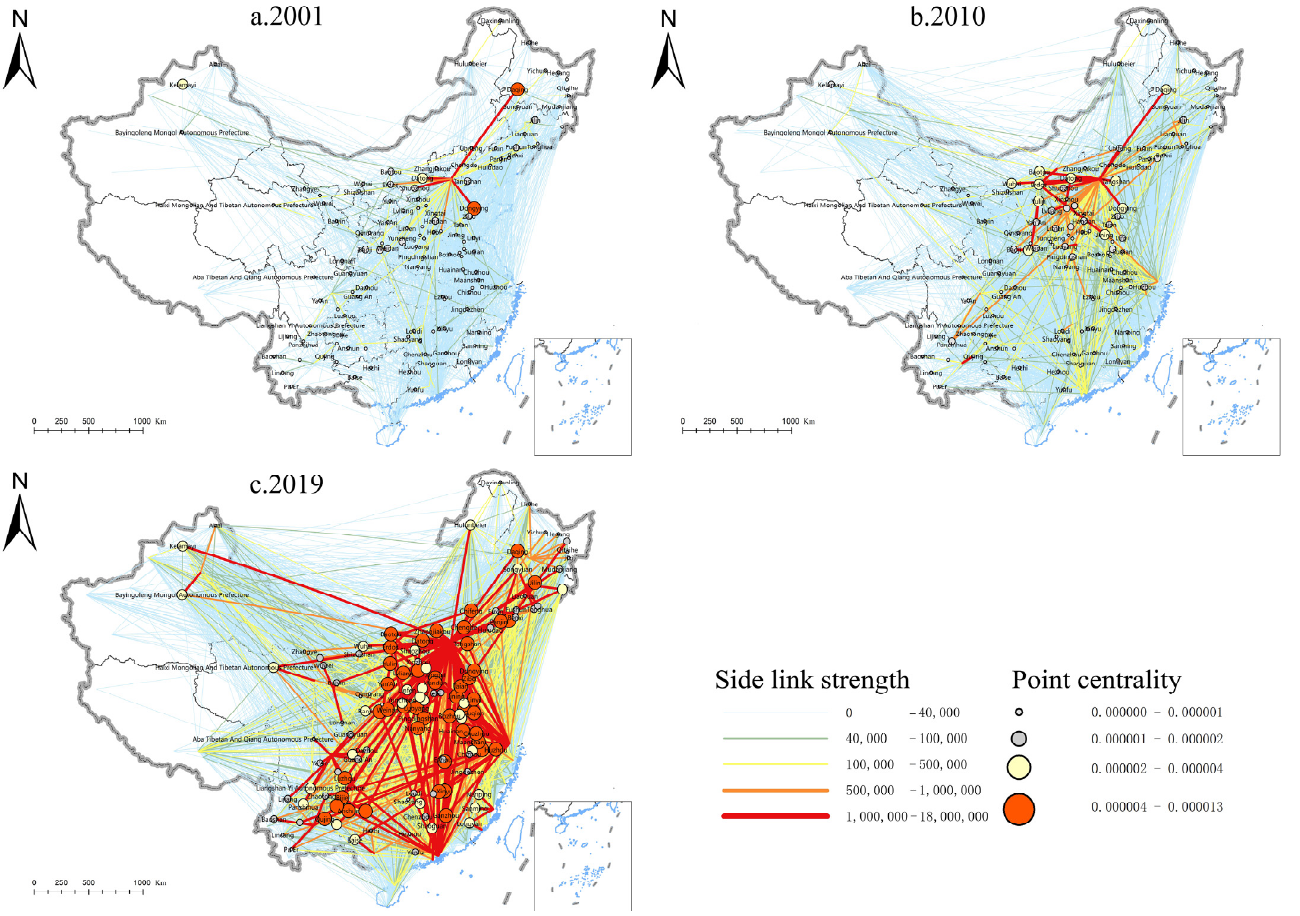
Figure 5. Spatial-temporal evolutionary characteristics of the proximity of investment